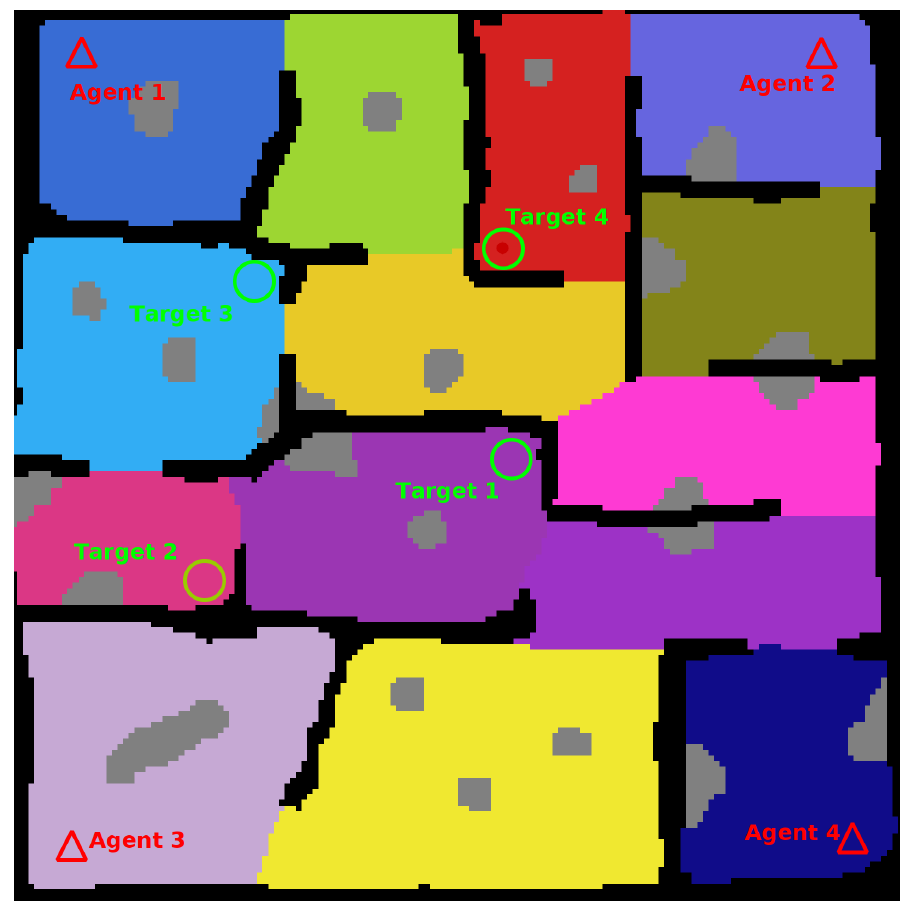
Figure 5. Complete Map. Black Cells : Known Obstacle Cells, White Cells : Explored Empty Cells, Coloured Cells : Unexplored Empty Cells (Search Regions), Grey Cells : Unknown Obstacle Cells, Triangles : Agent Spawn Locations, Circles : Target Spawn